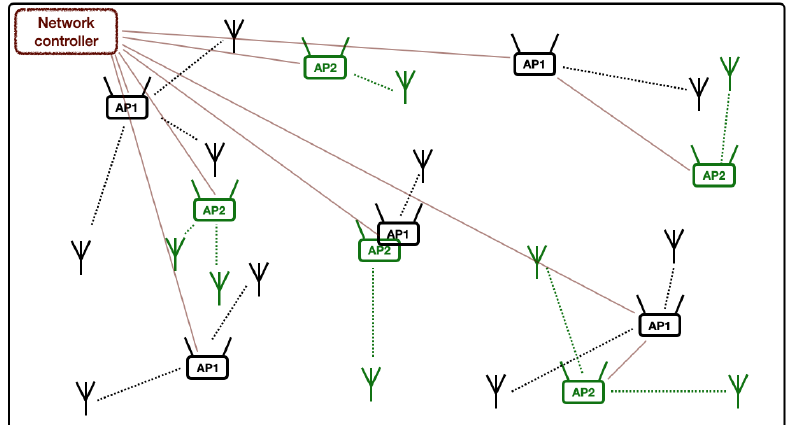
Figure 1. Overall system architecture with multiple wireless technologies. Clients wirelessly connect to an access point, and access points are connected to the network controller via a wired connection, or via another (1-hop) access point. Wired connections are represented by a straight line, whereas wireless connections are represented by a dotted